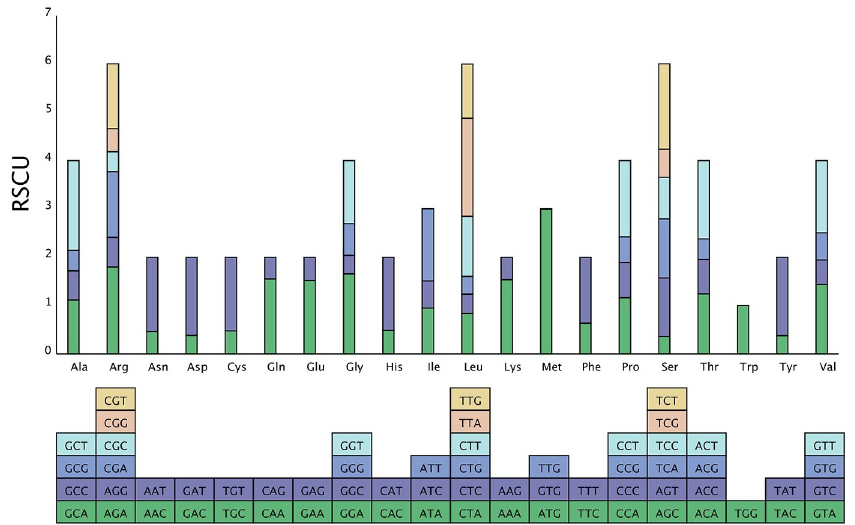
Fig 2. Codon contents of 20 amino acid and stop codons in all protein-coding genes of the broccoli cp